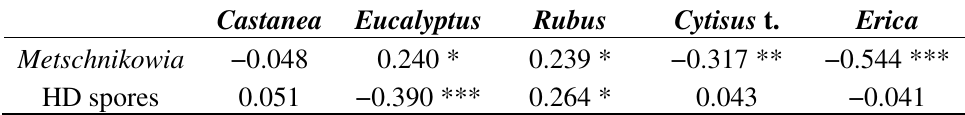
Table 4. Significant correlation coefficients for the microscopic analysis variables, based on Spearman’s test.